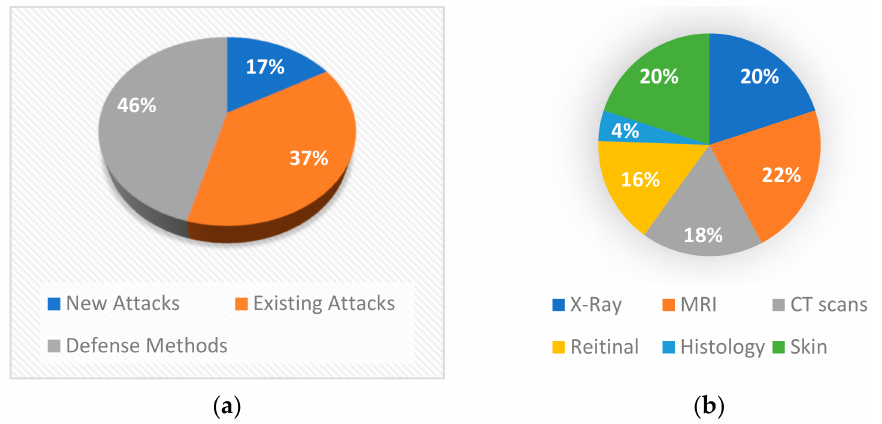
Figure 4. ( a ) Methods that were analyzed in this paper and ( b ) Image modalities that were